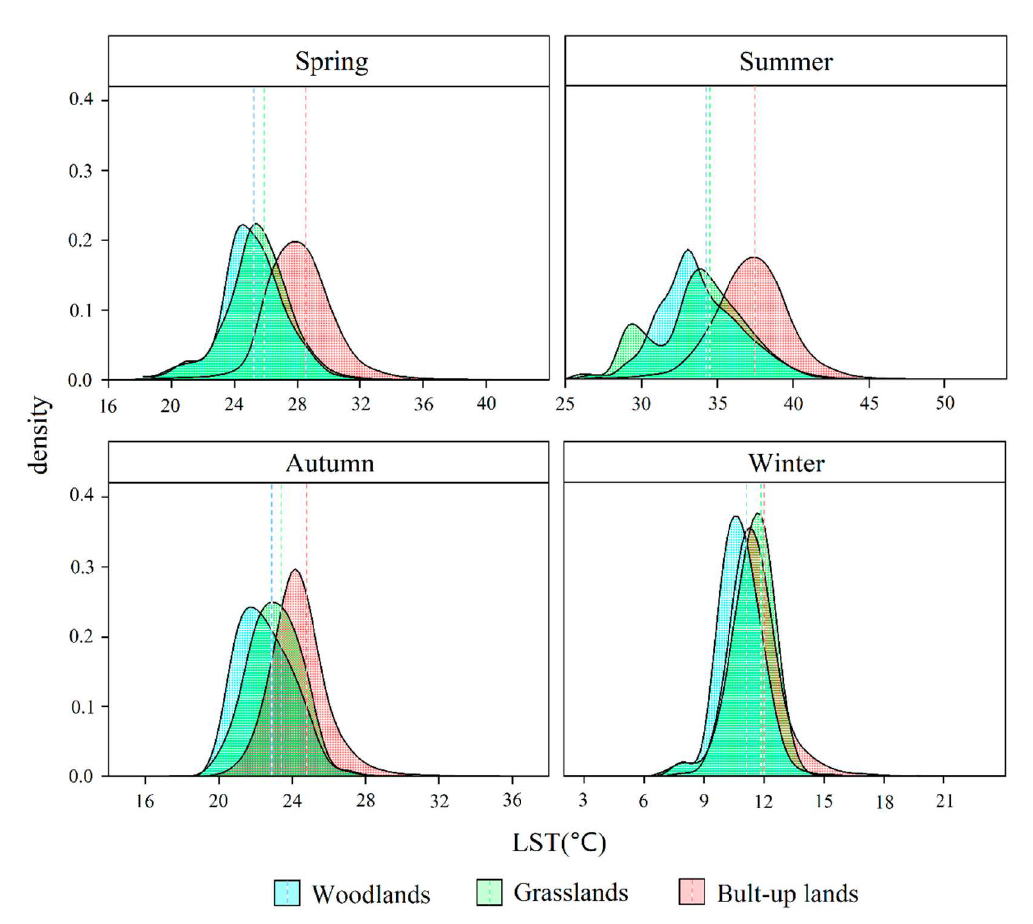
Figure 8. Density plot of LST for each season and for woodlands, grasslands, and built-up lands.